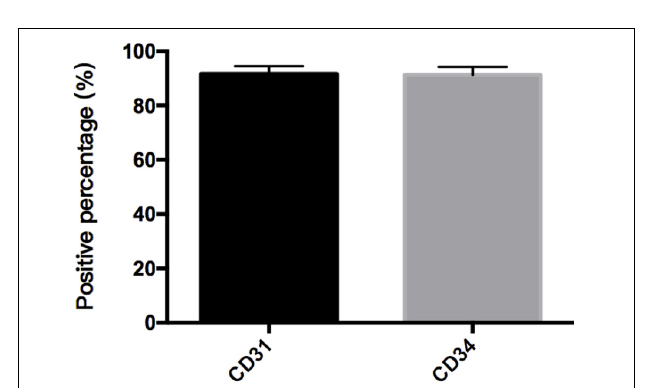
FIGURE 6 | Percent of CD31 and CD34 cells in cAVM-ECs. cAVM-ECs selected by FACS were immunostained for CD31 and CD34 antigens, respectively. The percent of CD31 positive cells was about (91.6 ± 2.86), and about (91.2 ± 2.96) for CD34.